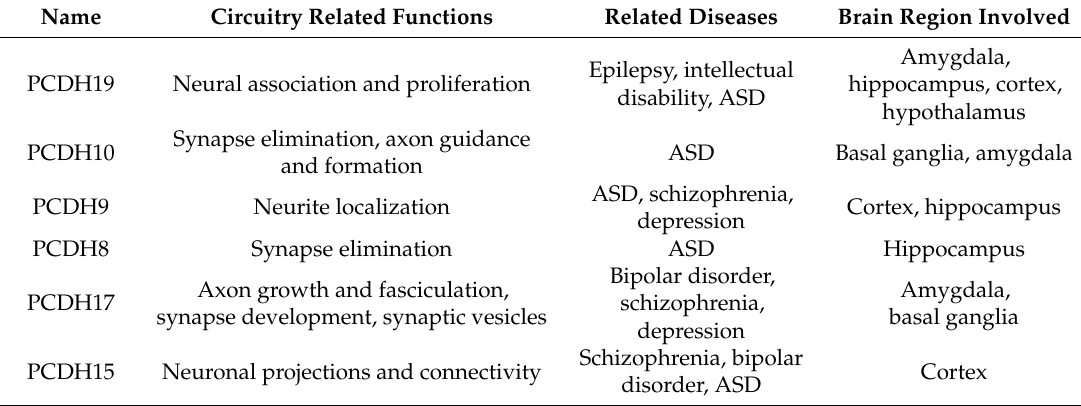
Table 2. PCDHs associated with neurodevelopmental disorders. Shown are the members of the PCDH family, their physiological functions in neuronal circuitry development, the disorders associated with their alterations and the main brain areas